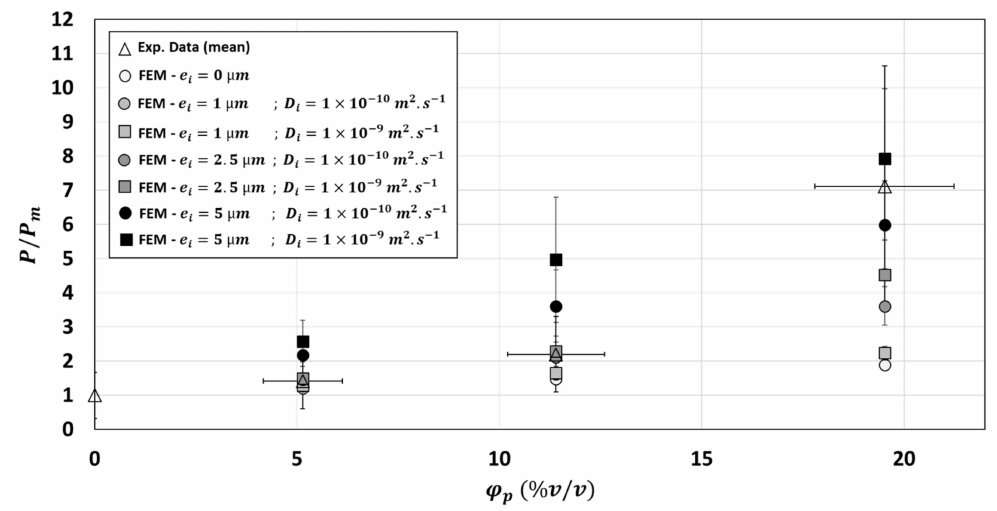
Figure 12. Comparison between experimental and numerical relative permeability: Effect of the particles volume fraction ϕ p and effect of the diffusivity D i and thickness e i of the